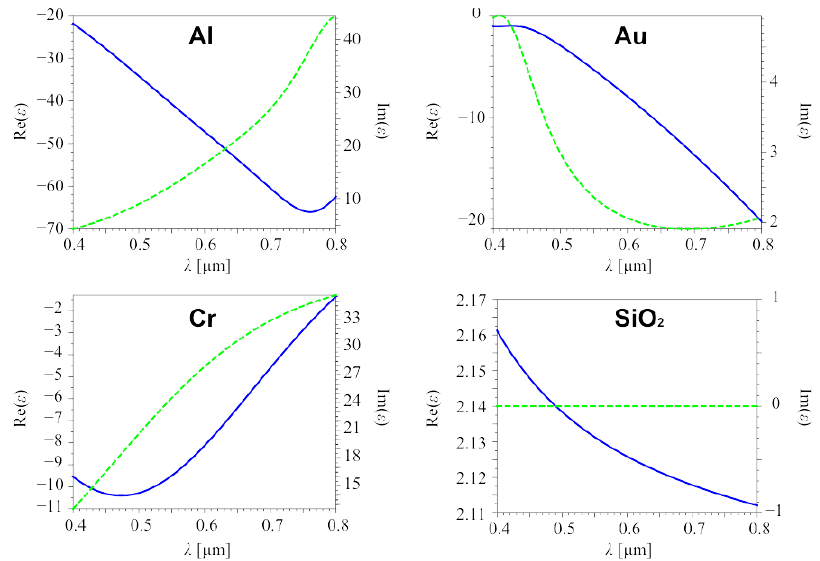
Figure 2. The permittivities of proposed materials plotted by using models (2) – (3) and parameters from Tables 2 – 5. Real part is presented by blue solid line, image part is presented by green dashed line.